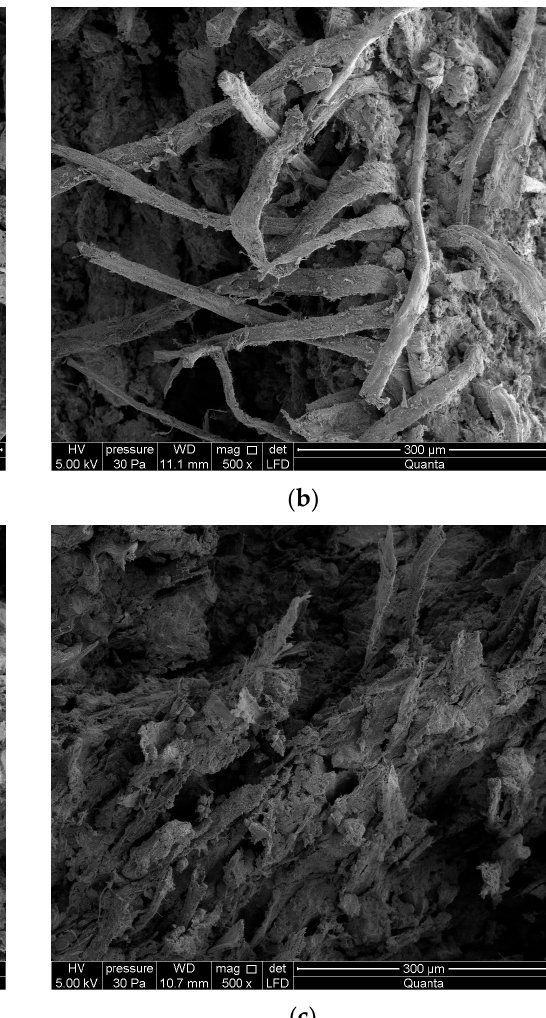
Figure 12. SEM images of boards: ( a ) series A R (magnification 1000× at top, 500× at bottom), ( b ) series A 1 , ( c ) series A 10 .